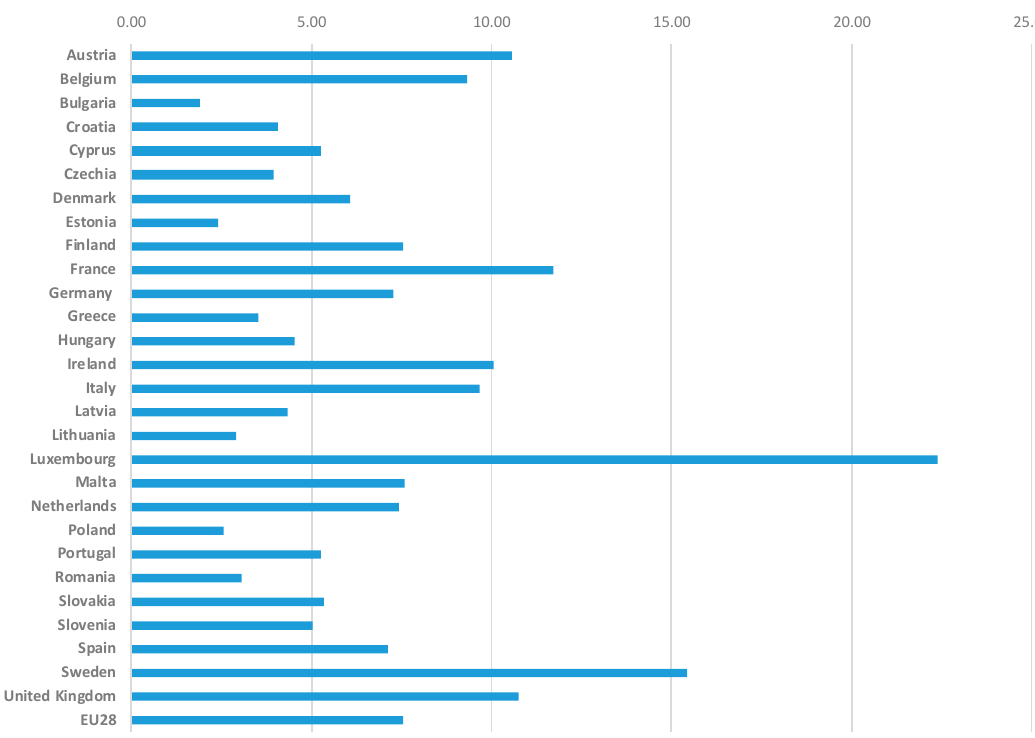
Figure 2. Average output (millions of euros) reduction caused by a reduction of 1000 tonnes of Greenhouse Gas (GHG) emissions through a reduction in demand by country.